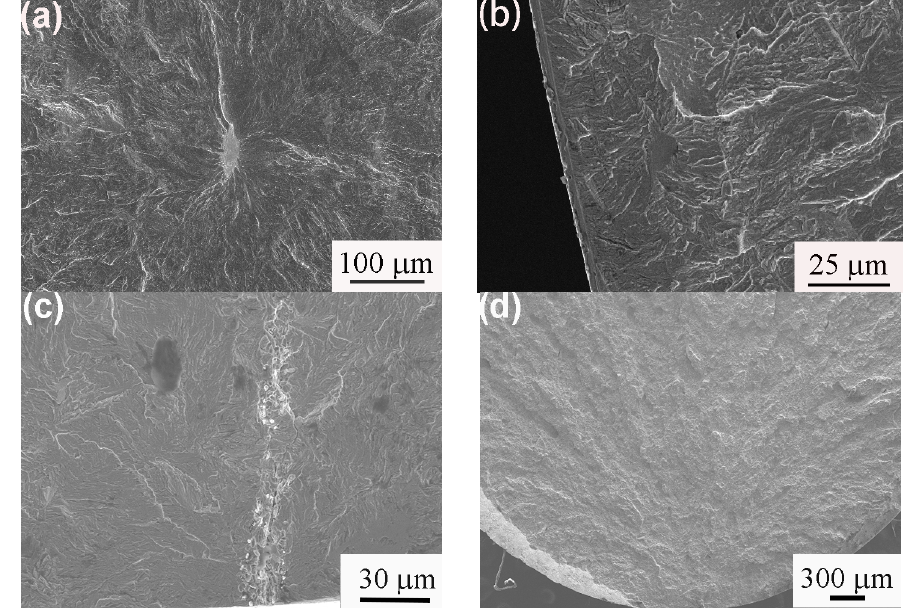
Figure 5. SEM fatigue fracture surface morphologies of isothermally-transformed samples. ( a ) A3 sample (1.4 GPa, 84,385 cycles), fracture initiate from MnS inclusion in sample interior; ( b ) A3 sample (1.6 GPa, 6206 cycles), fracture initiate from MnS inclusion in sample subsurface; ( c ) A1 sample (1.4 GPa, 61,429 cycles), fracture initiate from string of alumina inclusions on sample surface; ( d ) A1 sample (1.5 GPa, 9287 cycles), fracture initiated at or in close proximity to sample surface.